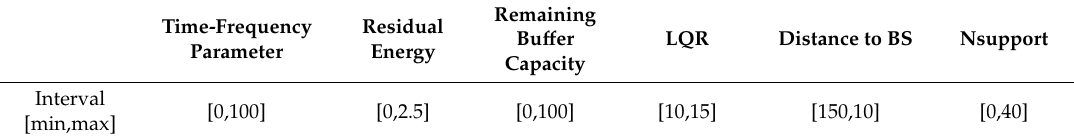
Table 3. Measured value after screening